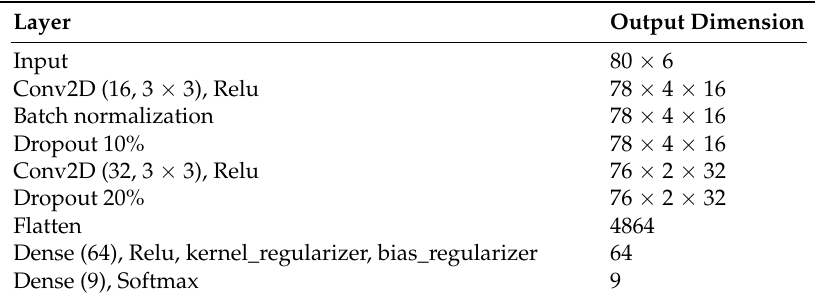
Table 2. Layers CNN (frame size = 80).